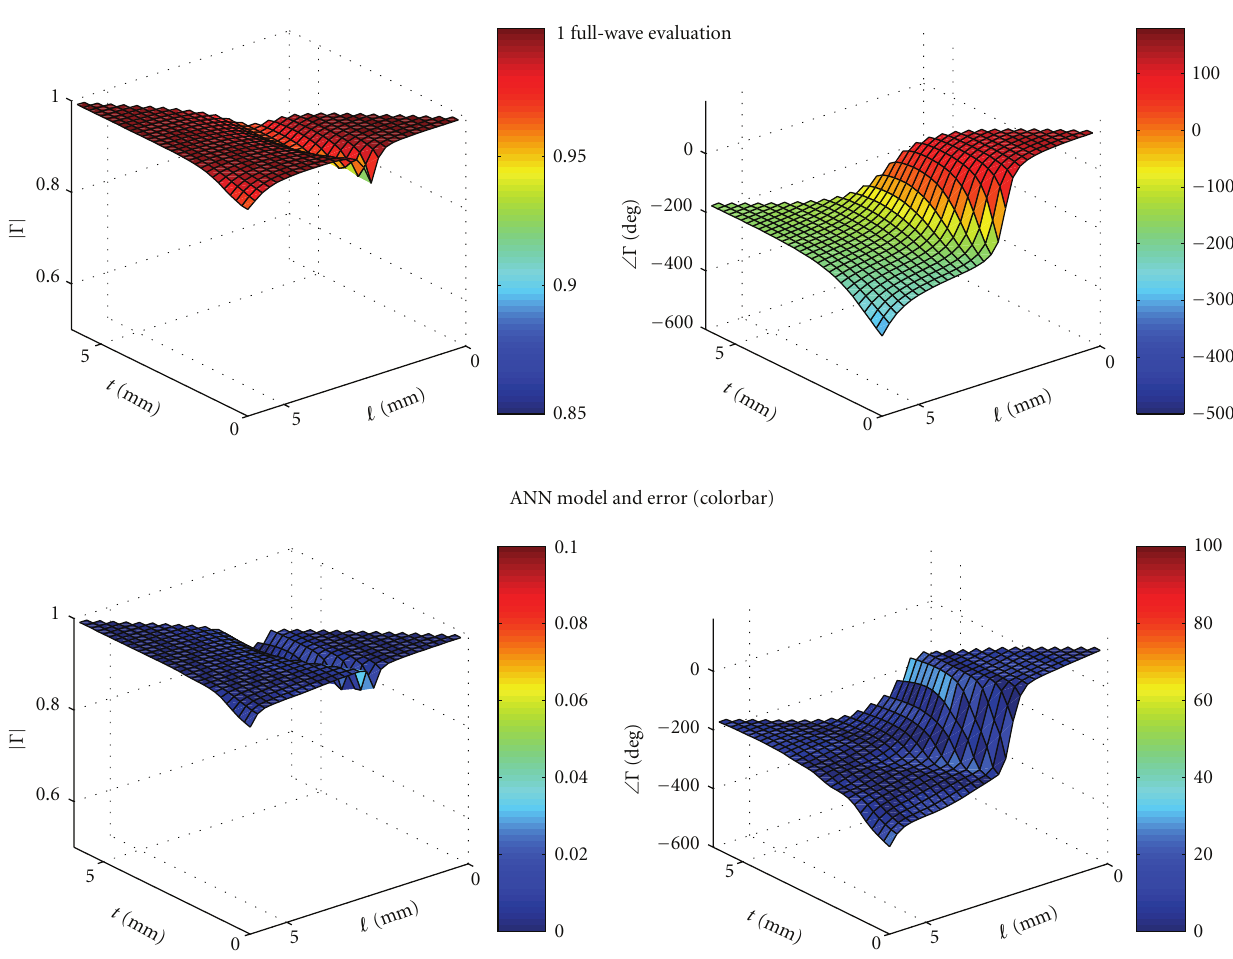
Figure 5: Reflection coe ffi cient amplitude (left) and phase (bottom) versus the two RA geometrical parameters (cid:2) and t of the modified Malta Cross, computed with direct full-wave (top) and reconstructed with the ANN (bottom). f = 10 . 7 GHz, θ inc = 0 ◦